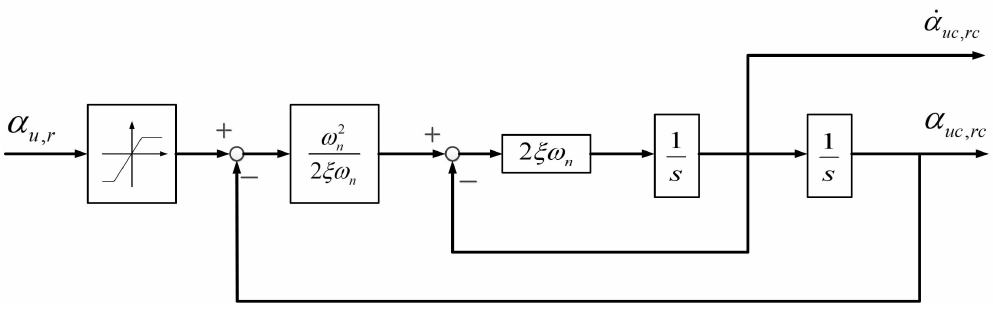
Figure 4. The filter block